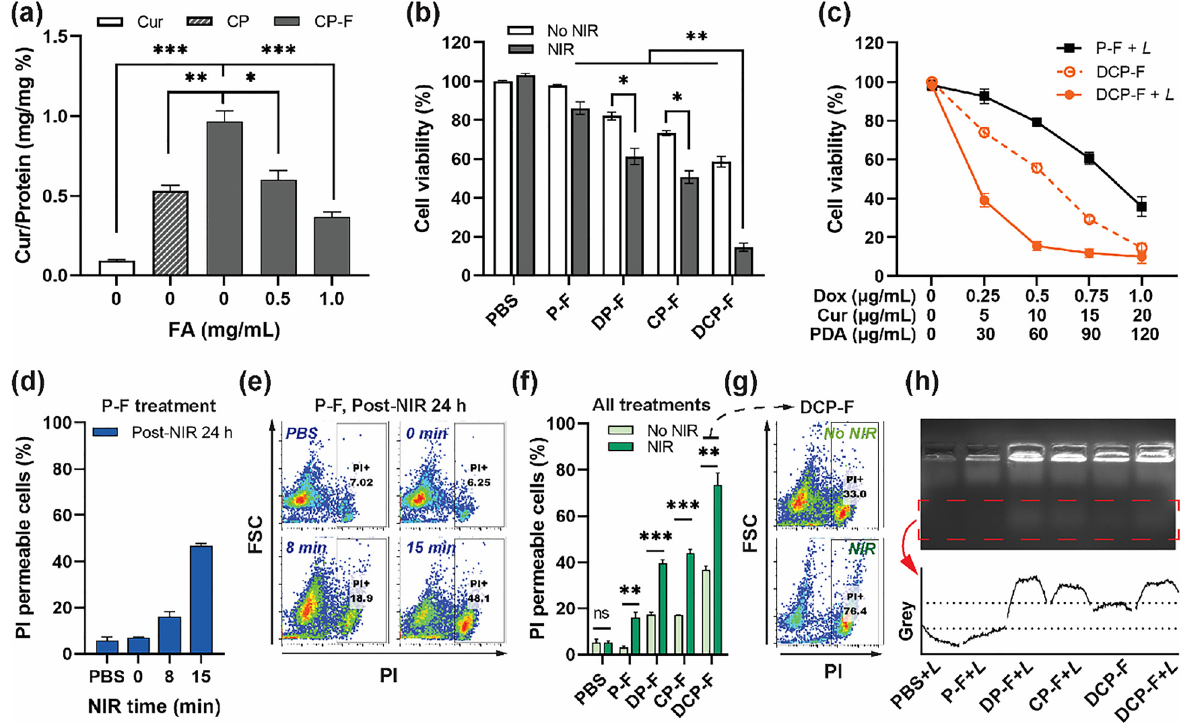
Figure 3: Cellular uptake, cytotoxicity and cell death profile. (a) Cellular uptake of free Cur, CP and CP-F NPs in 6 h incubation; (b) cell viability upon treatments; (c) dose-dependent cell viability of PTT-enhanced dual chemotherapy; cell membrane integrity loss with P-F NPs, (d) and (e) in the time-dependent manner and (f) with